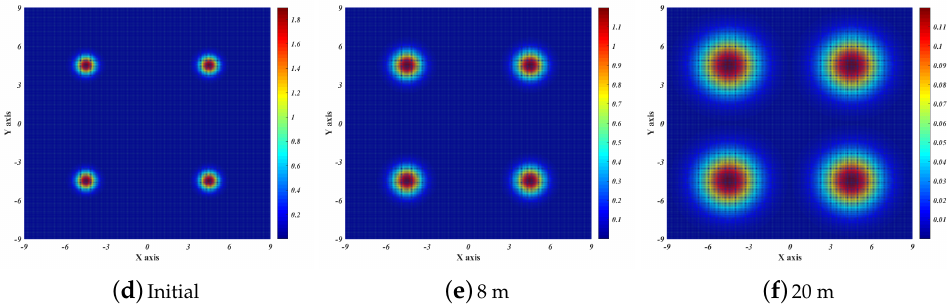
Figure 2. (Color online.) Light intensity distribution at different transmission distances of the four-state protocol over a pure sea water channel: ( a – c ) the three-dimensional views of the intensity distribution of the signal light at the position of initial, 8 m, and 20 m of the seawater channel, respectively; and ( d – f ) are their corresponding plane views.